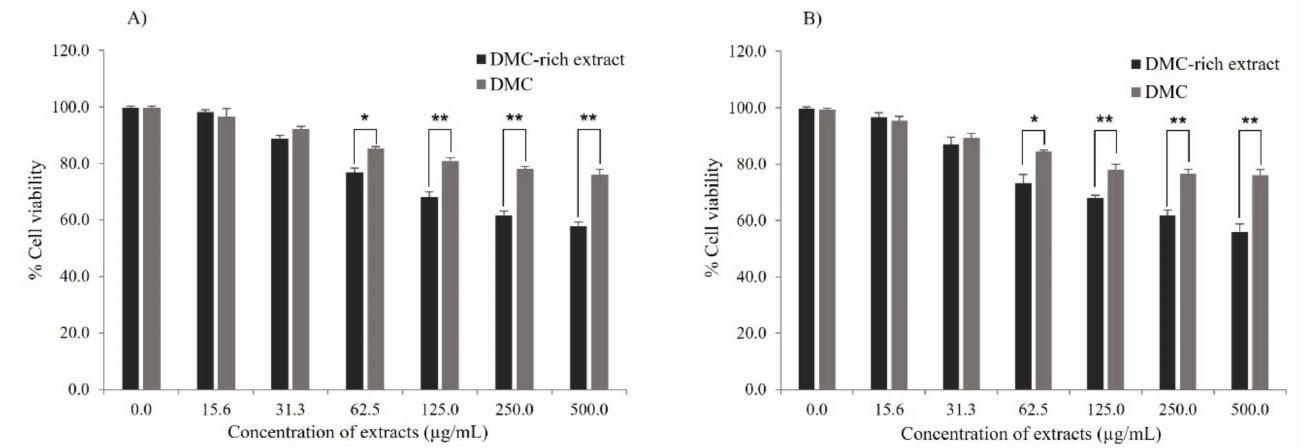
Figure 5. The effects of DMC-rich extract and DMC of S. nervosum on A549 cell viability at ( A ) 24 h and ( B ) 48 h. The data are an average of %cell viability ± SD of three studies. * p < 0.05 and ** p < 0.01 define statistically significant different.